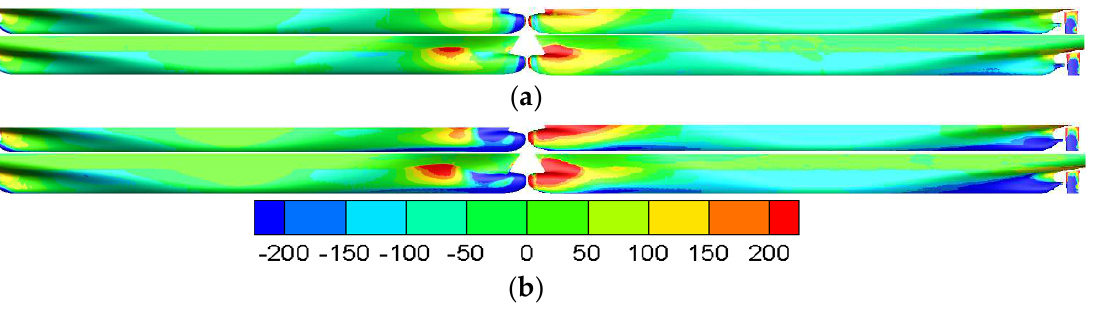
Figure 10. Dynamic pressure distribution on hull and rudder for simulations of double-body flow (top) and water–air flow (bottom). ( a ) Fr = 0.201, r (cid:48) = − 0.2. ( b ) Fr = 0.201, r (cid:48) = − 0.6.